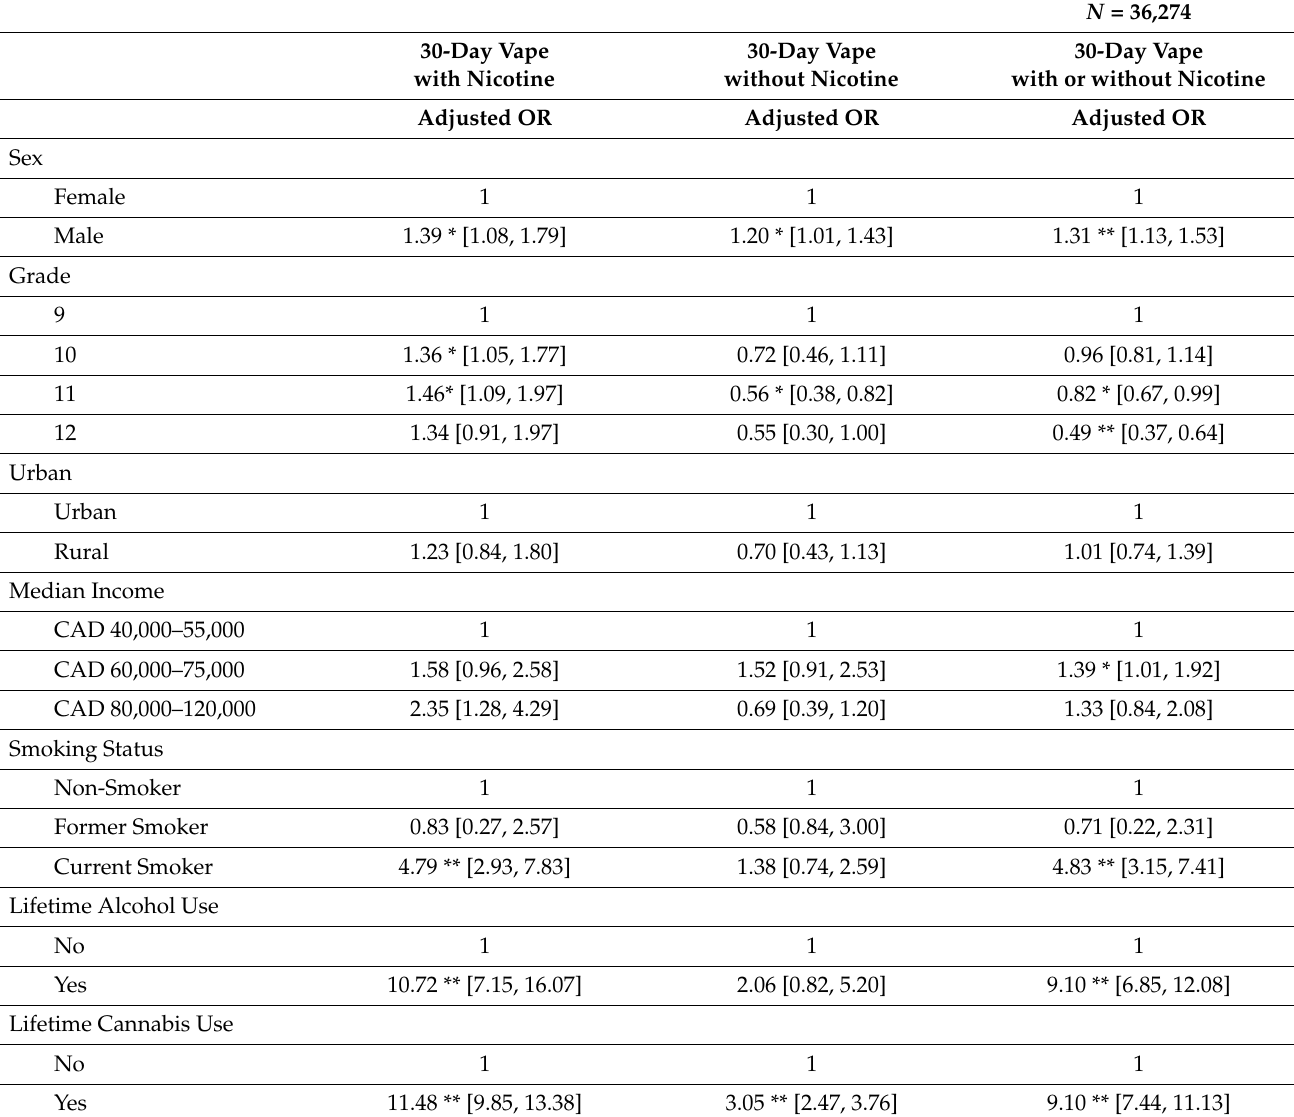
N = 36,274 30-Day Vape 30-Day Vape without Nicotine with or without Nicotine